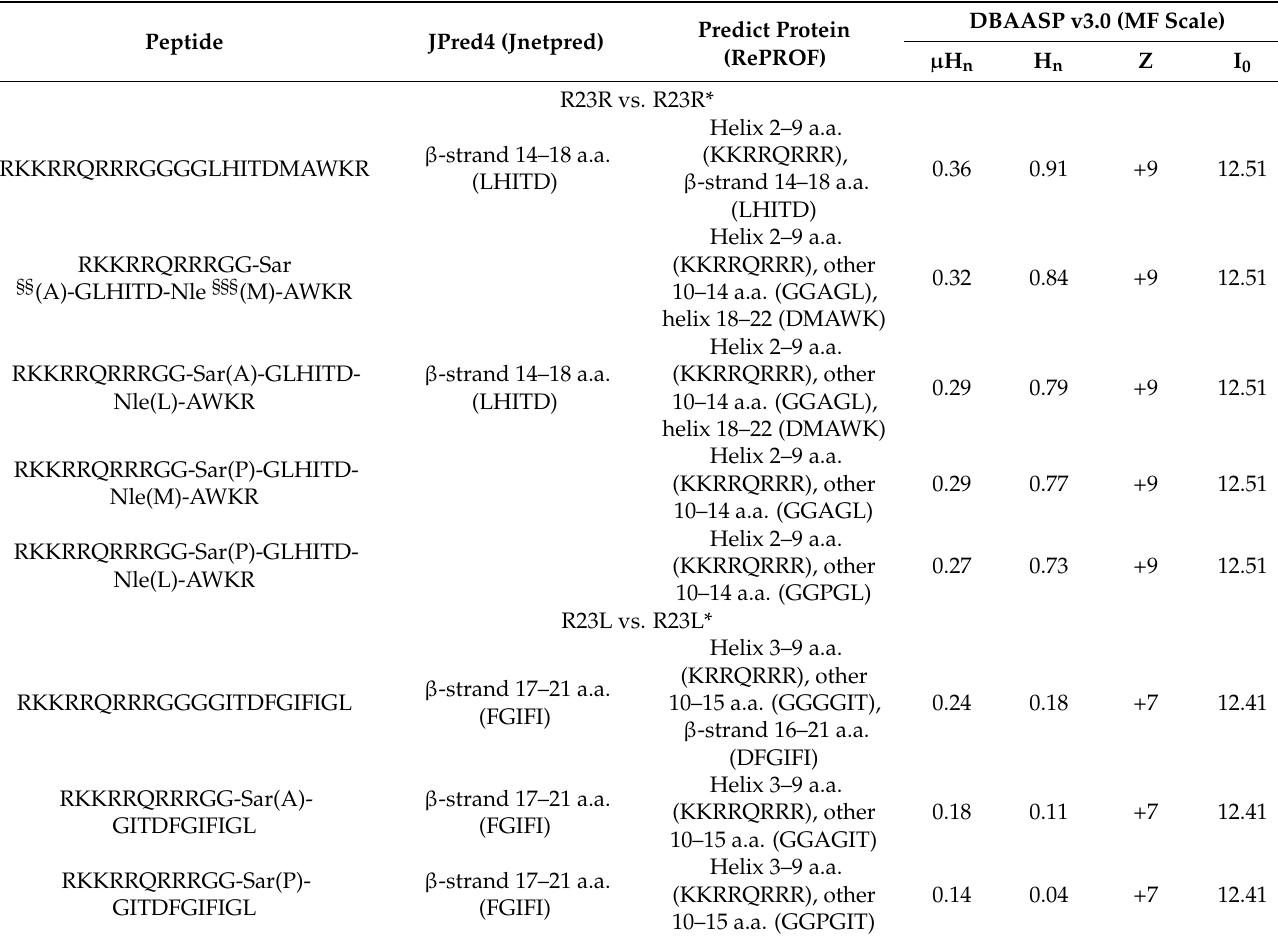
Table 1. Prediction of the secondary structure § and physicochemical properties of the peptides.